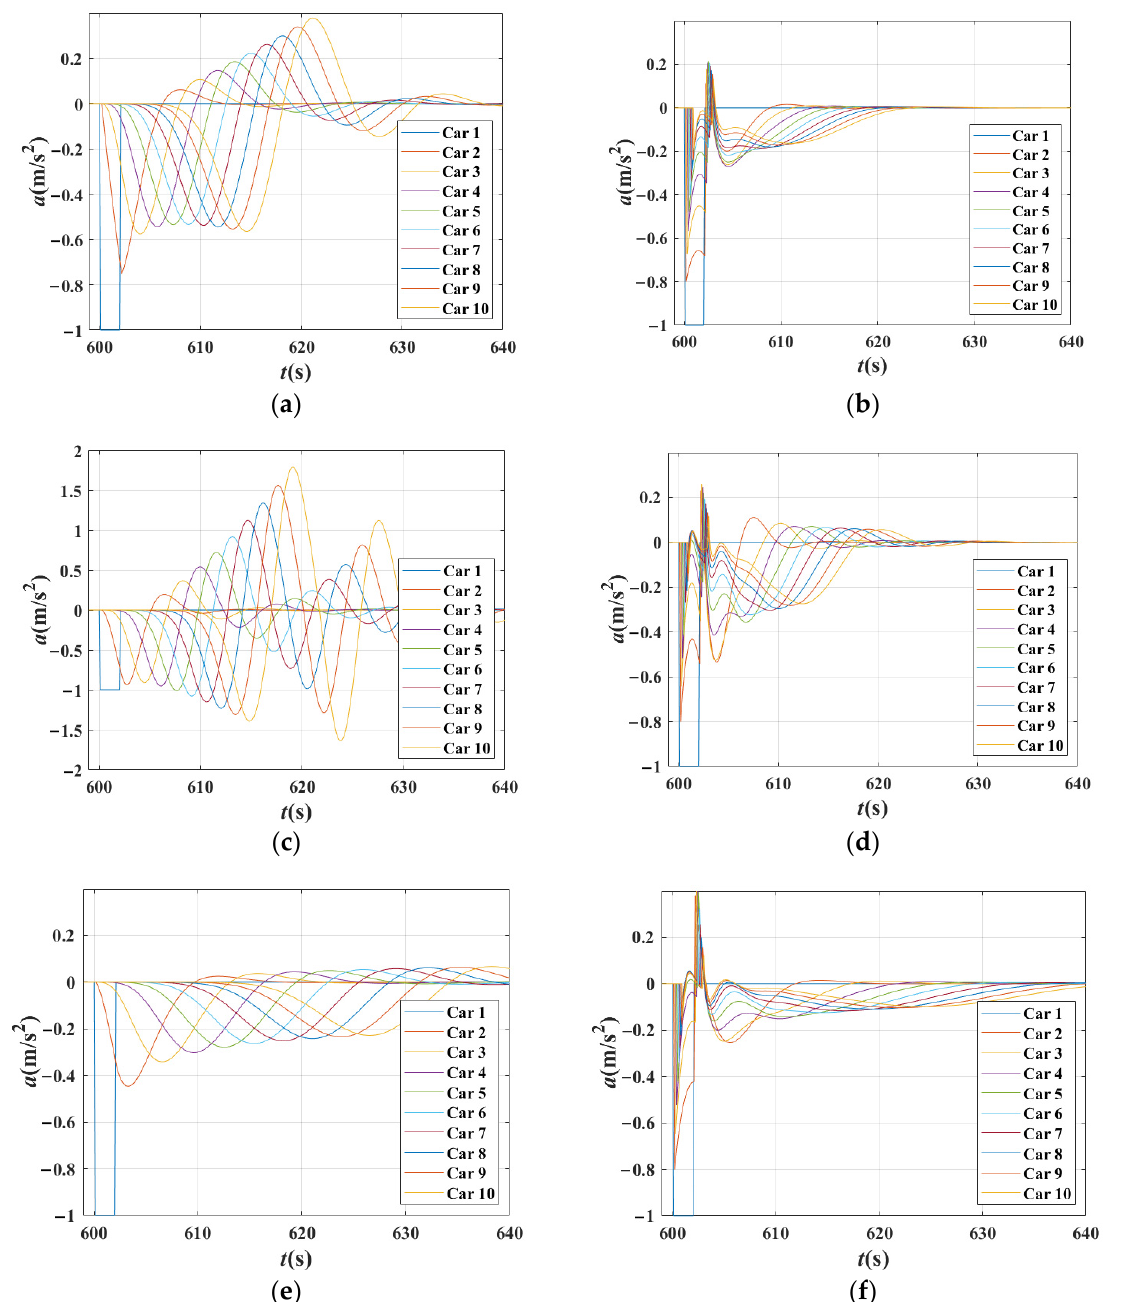
Figure 8. Acceleration changes in the traffic when the basic model is the FVD, OV, and ACC model. ( a ) Acceleration changes in the traffic when the basic model is the FVD and β 1 = 0, β 2 = 0, ∆ x = 20 m; ( b ) Acceleration changes in the traffic when the basic model is the FVD and β 1 = 0, β 2 = 0.8, ∆ x = 20 m; ( c ) Acceleration changes in the traffic when the basic model is the OV model and β 1 = 0., β 2 = 0, ∆ x = 20 m; ( d ) Acceleration changes in the traffic when the basic model is the OV model and β 1 = 0.8, β 2 = 0, ∆ x = 20 m; ( e ) Acceleration changes in the traffic when the basic model is the ACC model and β 1 = 0.0, β 2 = 0, t hw = 2.5 s ACC; ( f ) Acceleration changes in the traffic when the basic model is the ACC model and β 1 = 0.8, β 2 = 0.0, t hw = 2.5 s.